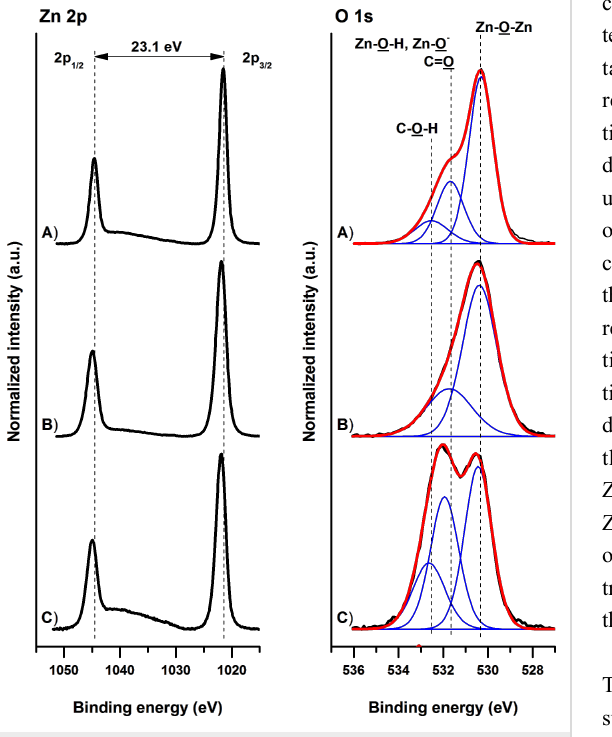
the full width at half maximum (FWHM) of the pristine nano- columns is about 1.8 eV, the FWHM of H- and O-plasma treated ZnO structures increased to 2.3 and 2.0 eV,